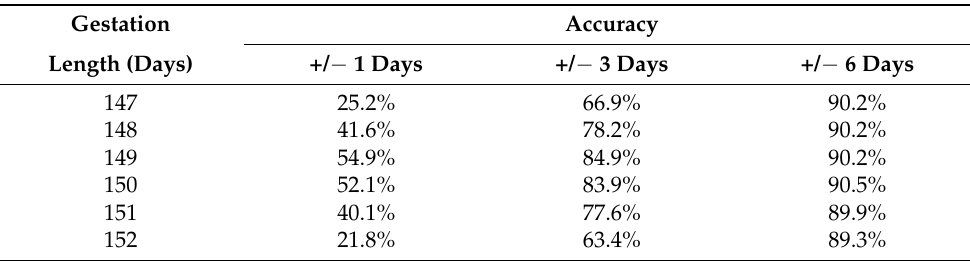
Table 2. The effect of using different gestation lengths on the proportion of ewes lambing within ± 1, ± 3 and ± 6 days of the date predicted.